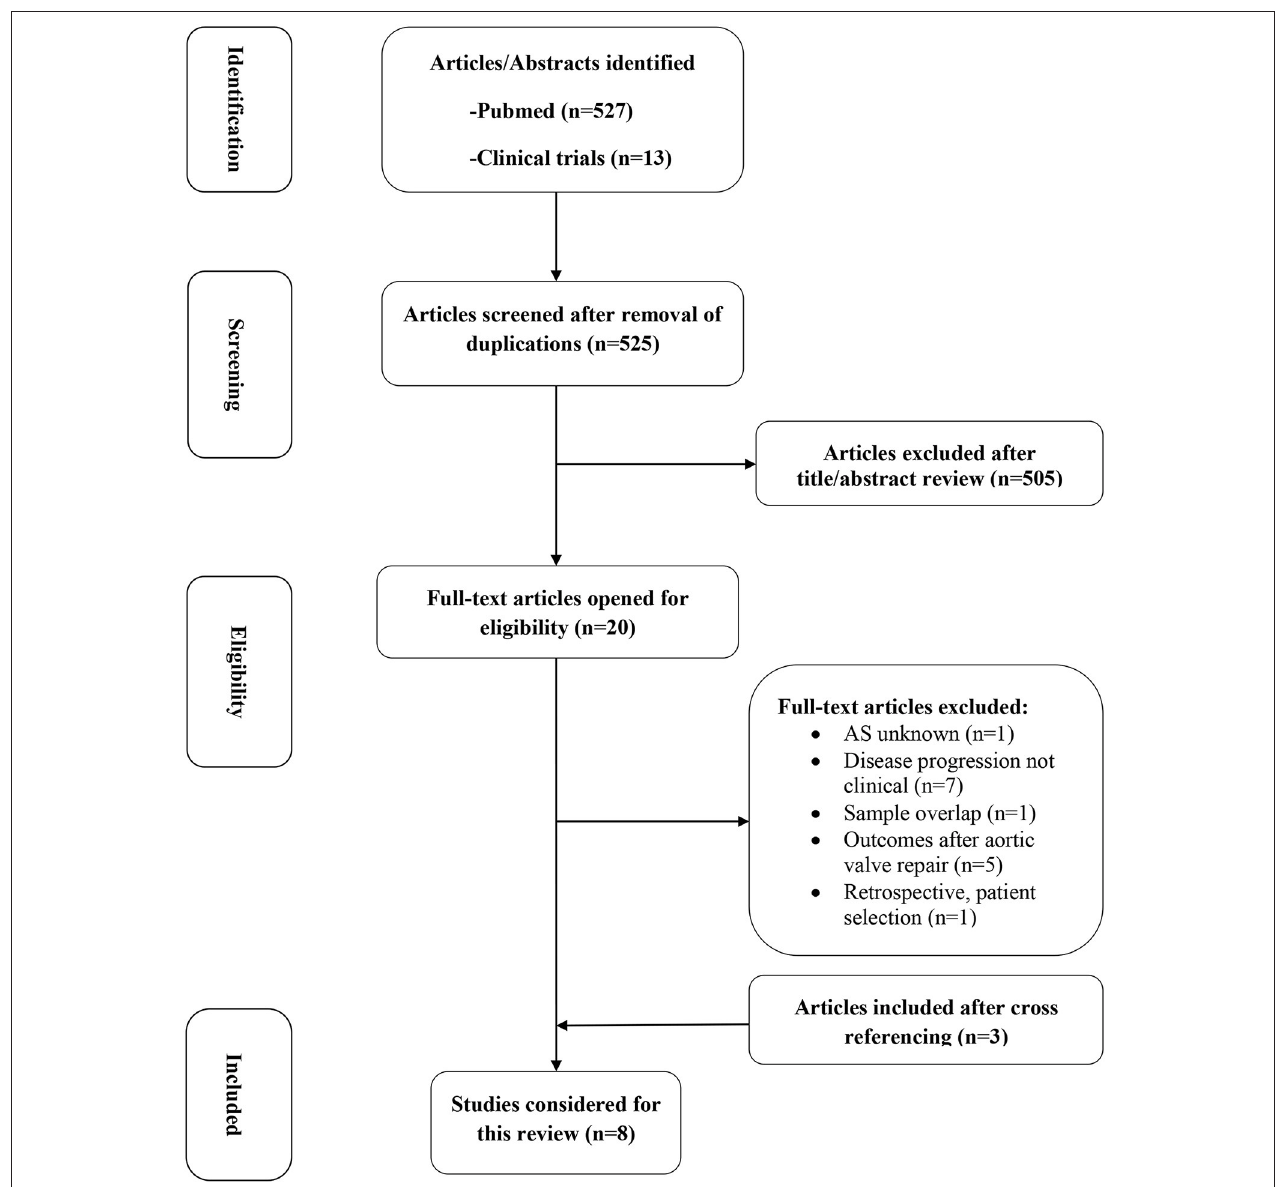
FIGURE 1 | PRISMA flowchart of study